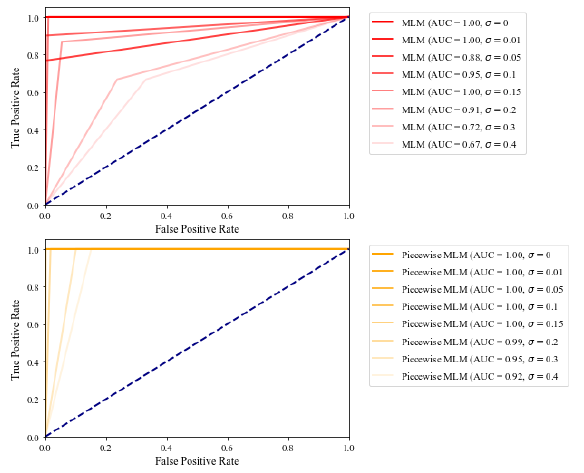
Figure 7: Comparison of the ROC-curves of the MLM and piece- wise MLM with a different amount of noise in the data (the Col- orChecker dataset). The noise drawn from the uniform distribu- tion was added to each pixel. The level of the noise is denoted with σ . The ROC curves show that both approaches had no false positives with a low noise level. When the noise level increases, the piecewise MLM was significantly more robust with respect to the noise than the MLM.